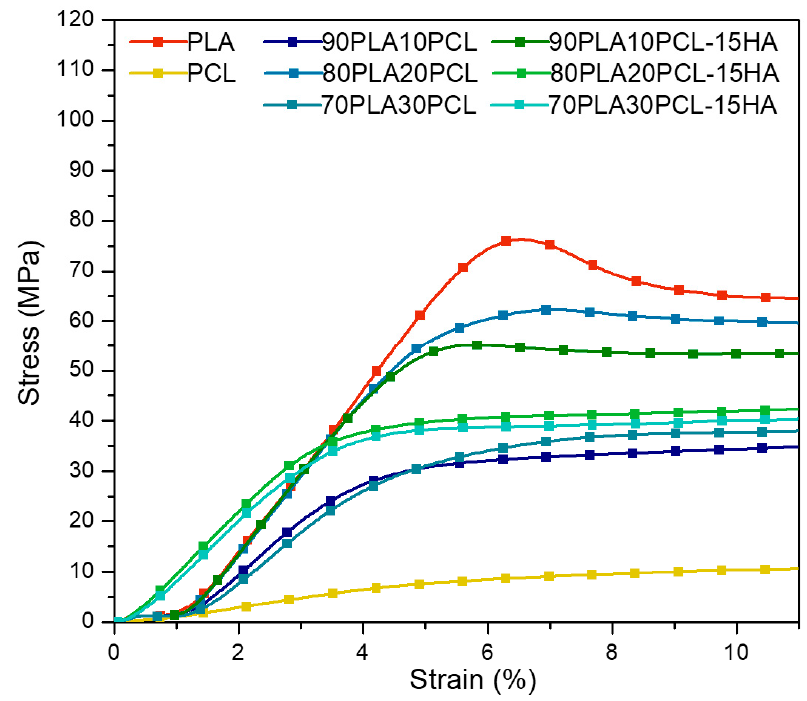
Figure 3. Typical stress–strain curves obtained from compression tests on all materials. Table 4. Elastic modulus and compressive strength for all different materials obtained from com- pression tests as well as reference values of human bone tissue.